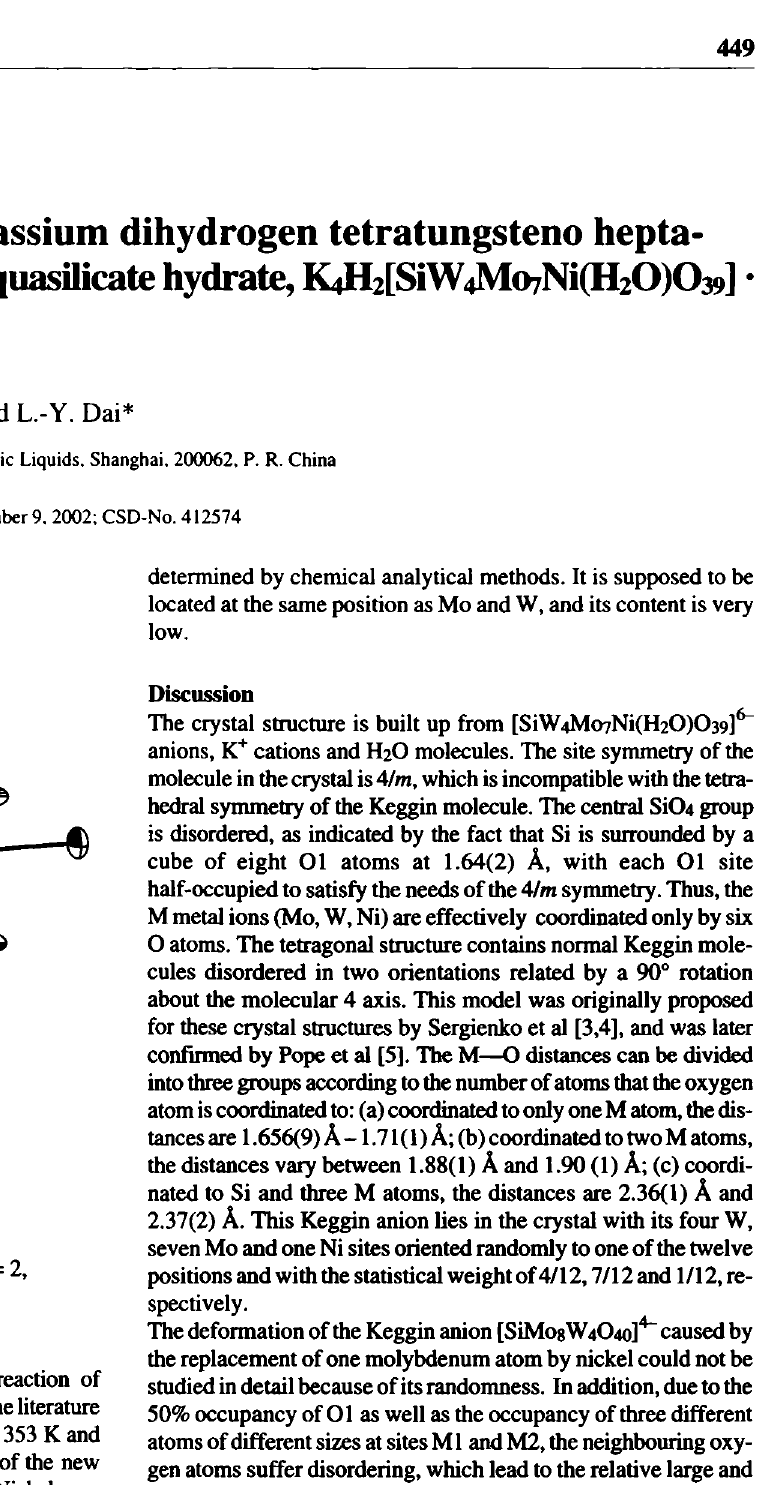
Table 1. Data collection and